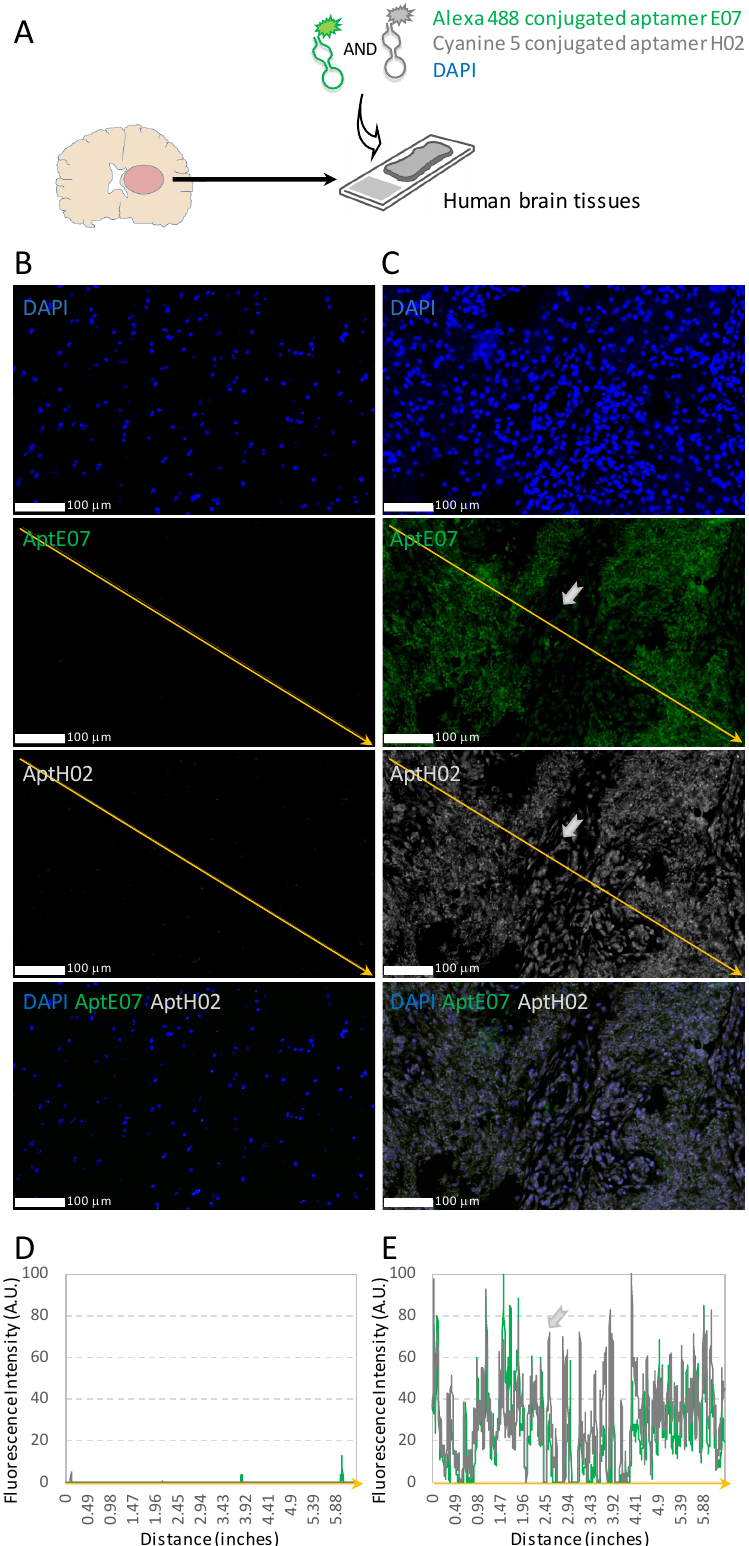
Figure 5. Dual labeling with aptamers targeting integrin α 5 and EGFR. ( A ) Schematic depicting detection via AHF simultaneously using two aptamers, aptamers E07 and H02, conjugated to two different fluorophores (not to scale). In ( B , C ), we show human epileptic brain and GBM tissues, respectively.